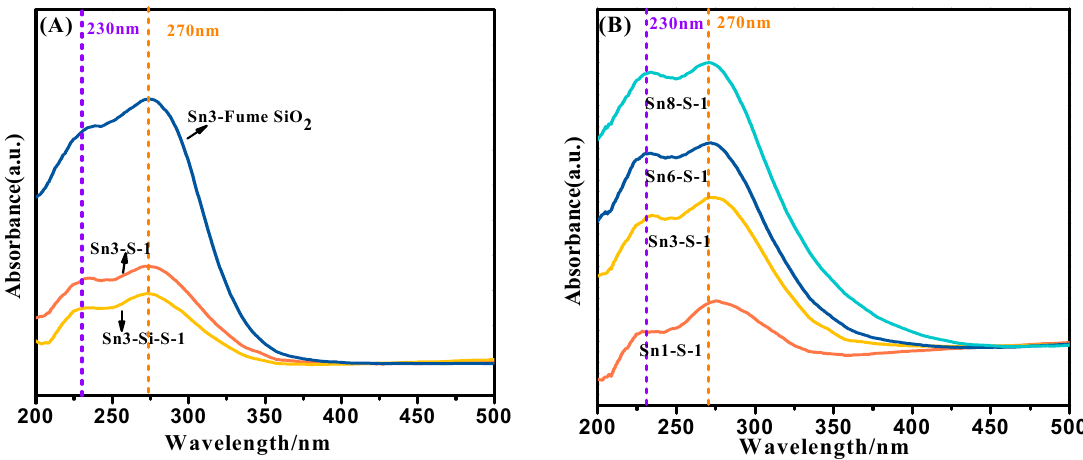
Figure 2. UV–VIS spectra of Sn-containing catalysts with di ff erent matrixes ( A ) and the Sn-containing defective S-1 zeolite catalysts with di ff erent Sn loadings ( B ).